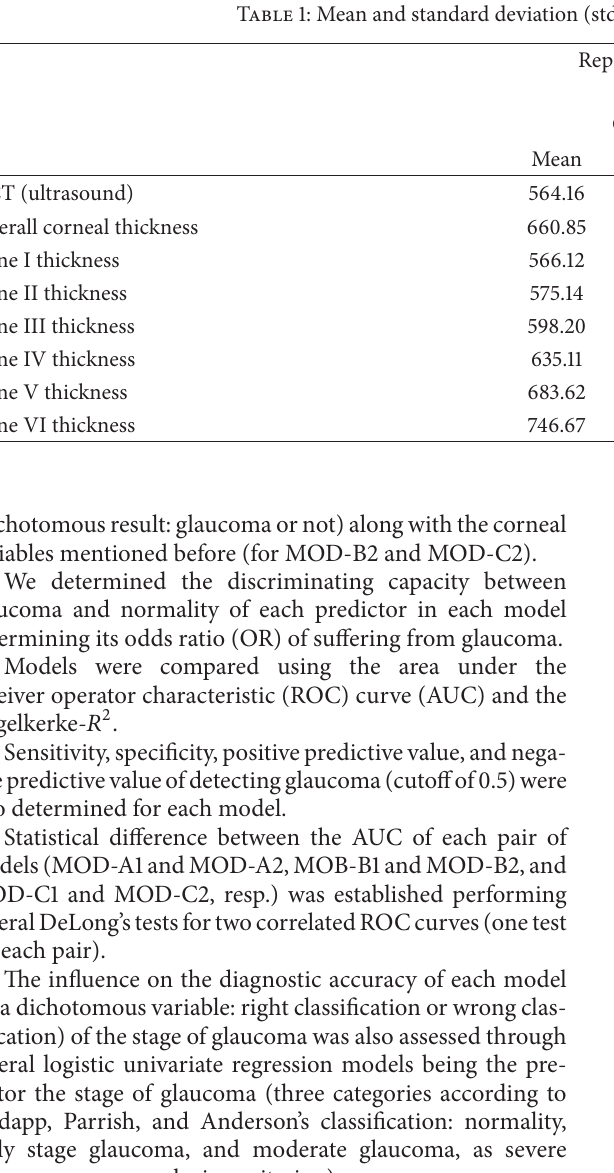
Figure 3: ROC curve for model